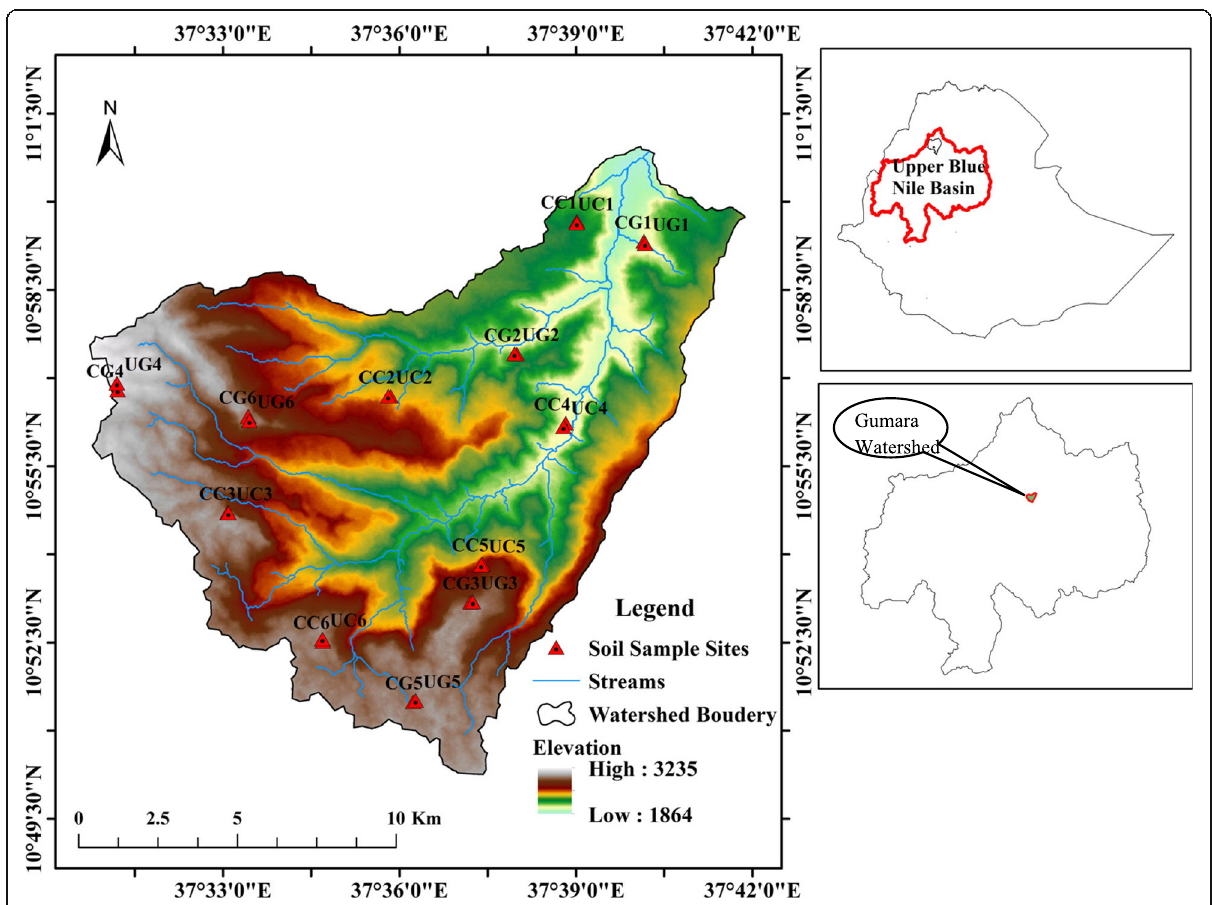
Fig. 1 Map of Gumara watershed, in Upper Blue Nile River Basin,